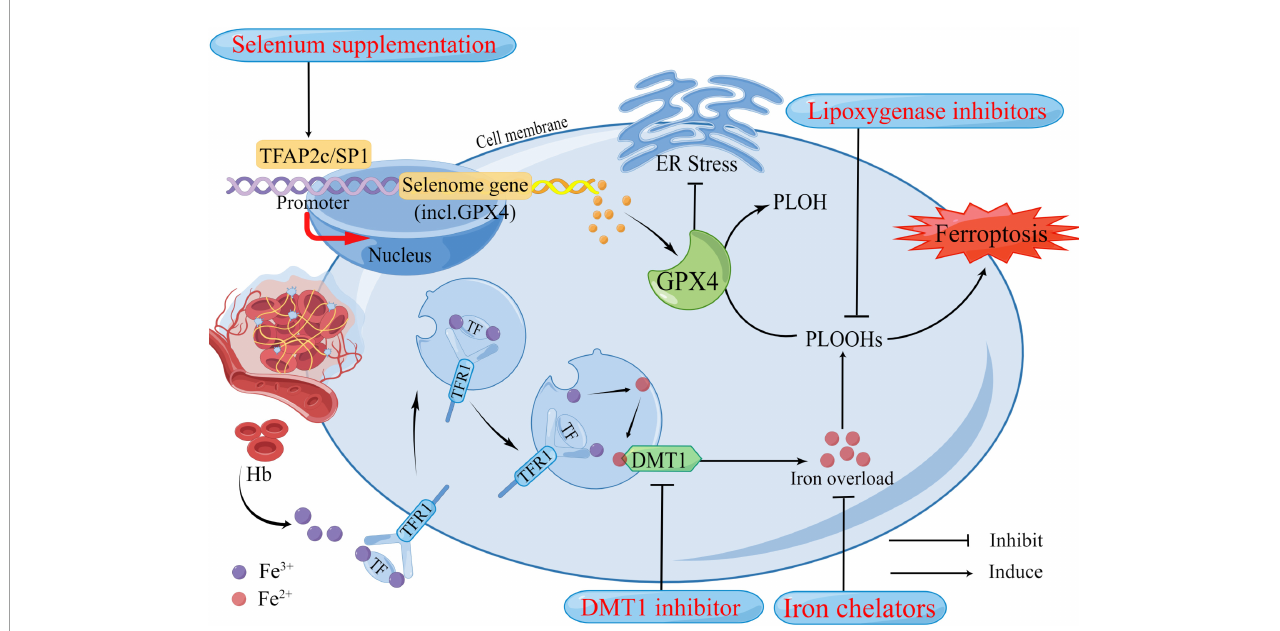
FIGURE2 Potential therapeutic strategies based on neuronal ferroptosis after Intracerebral hemorrhage (ICH). Several regulators in the ferroptosis pathway are highlighted in the treatment of ICH. These regulators have been confirmed to play roles in ferroptosis. After ICH, in addition to the primary brain injury caused by the hematoma compressing the surrounding brain tissue, Hb, iron, and other neurotoxic substances released by the hematoma also contribute to the increase of reactive oxygen species (ROS), resulting in ferroptosis and cause secondary brain injury. DMT1 and Iron chelators could reduce iron overload from two aspects, respectively. GPX4 acts as an antioxidant that inhibits ER stress and reduces lipid peroxides in cells to harmless PLOH to inhibit ferroptosis. It has been well established that GPX4 deficiency causes neuronal ferroptosis after ICH. Selenium supplementation augments GPX4 and other genes in this transcriptional program, the selenome, via coordinated activation of the transcription factors TFAP2c and Sp1 to protect neurons. Hb, hemoglobin; Fe3+, ferric iron; Fe2+, ferrous iron; TF, transferrin; TFR1, transferrin receptor 1; DMT1, divalent metal transporter 1; Gpx4, glutathione peroxidase 4; PLOH, phospholipid alcohol; PLOOHs, phospholipid hydroperoxides; ER, endoplasmic reticulum.